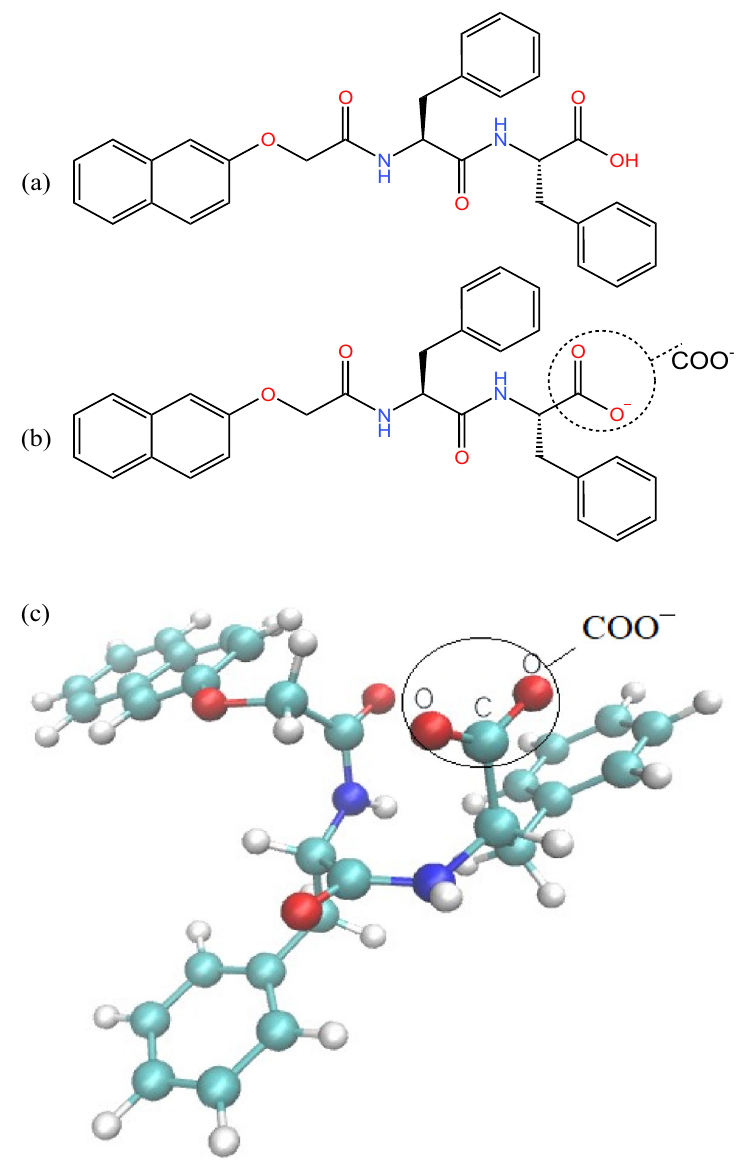
Figure 1. Structure of 2NapFF. ( a ) the molecule of 2NapFF; ( b ) at high pH, the deprotonated structure with a negative charge; ( c ) the ball and stick model (CPK) of the deprotonated